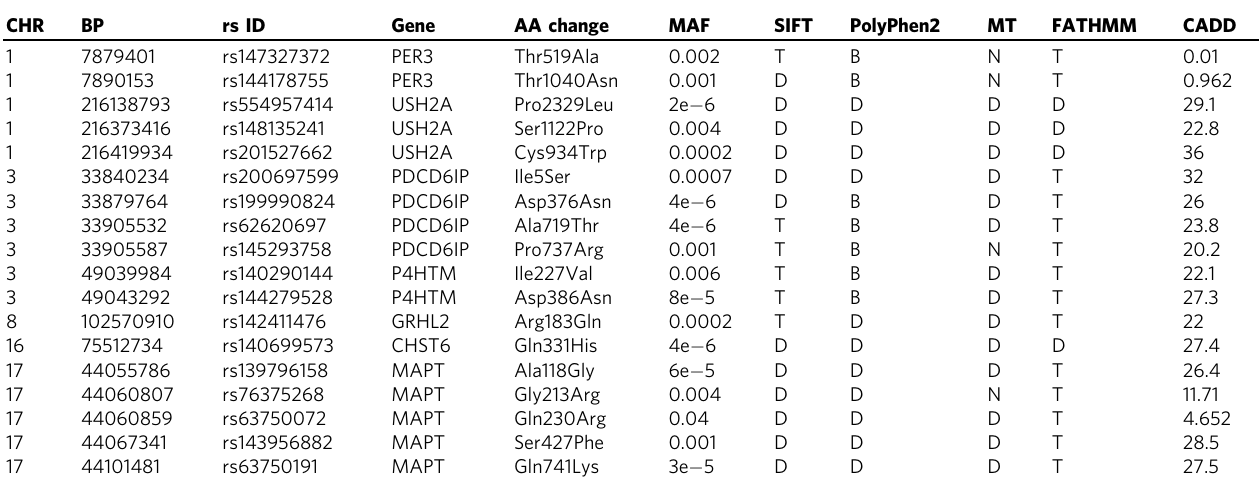
Table 2 Potential missense causal variants in prioritized